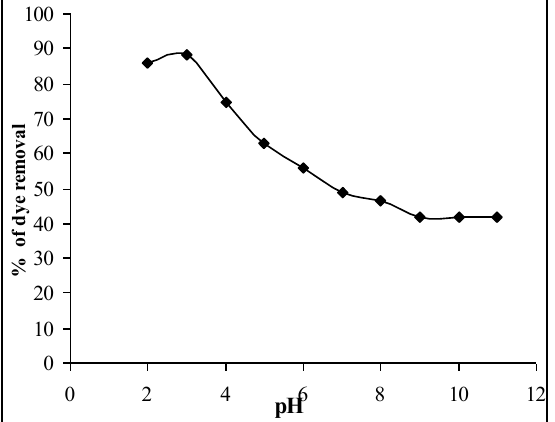
Figure 4 . Effect of pH for Adsorption of Reactive Red onto